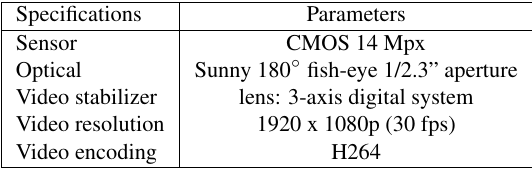
Table 1. Specifications of the Parrot Bebop